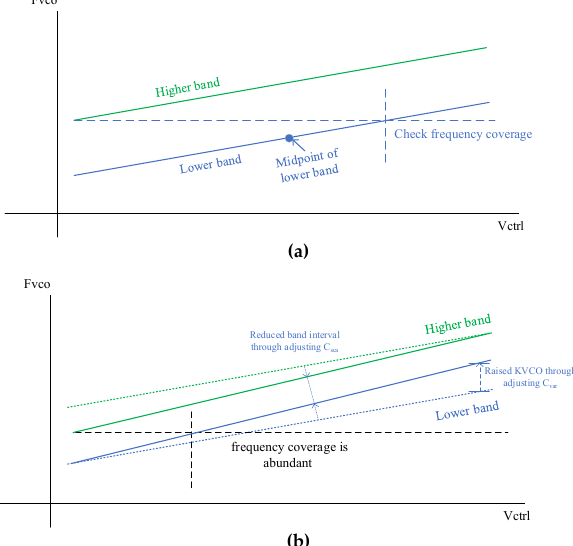
Figure 5. Optimization of a Class-C VCO ( a ) Frequency coverage is not enough as lowest frequency on next band should cover at least half the current bandwidth; ( b ) Optimizing the VCO design parameters to meet the design requirements.